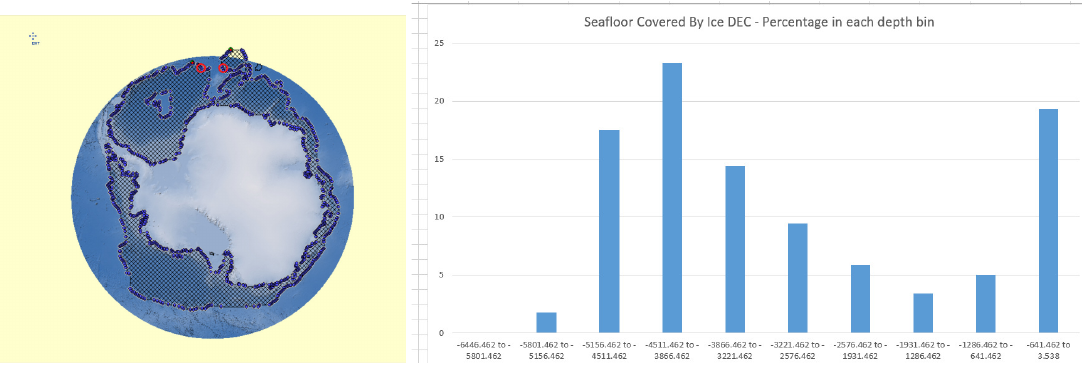
Figure 1. Antarctic seafloor covered by ice in December (denoted “DEC” in the figure) 2019 (left figure). Percentage distribution of this ice-covered seafloor in 10 depth bins (right